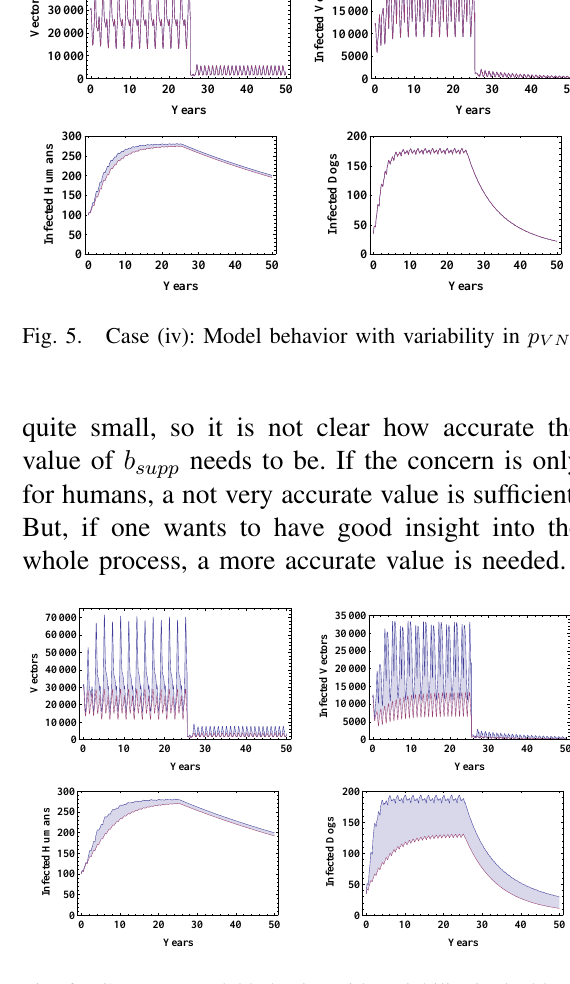
Fig. 6. Case (v): Model behavior with variability in the blood supply b supp